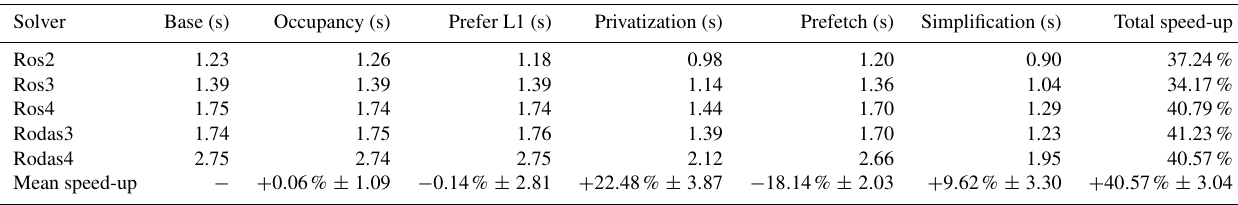
Table B3. Results running the kernel on a P100 CUDA-enabled accelerator hosted in a node equipped with two POWER8 processors. In the P100 platform, we removed the prefetch optimization, as it decreases the performance in all